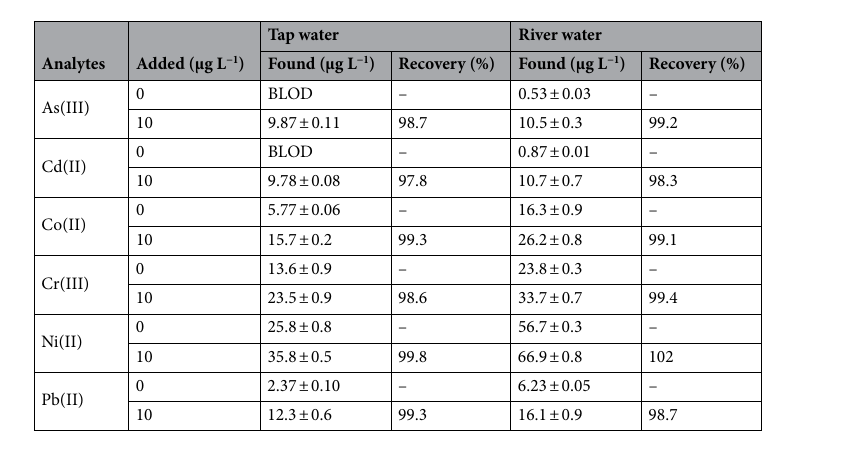
Table 5. Analysis of real samples using